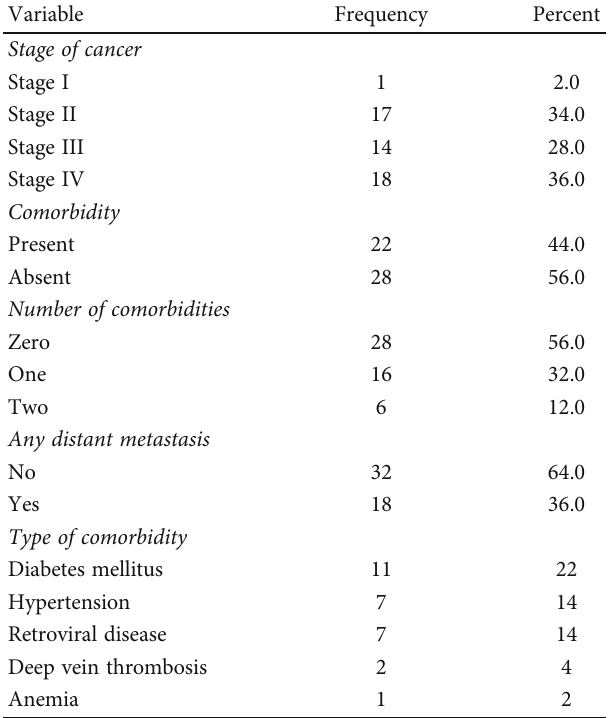
Table 2: Clinical characteristics of HER2-positive breast cancer patients.